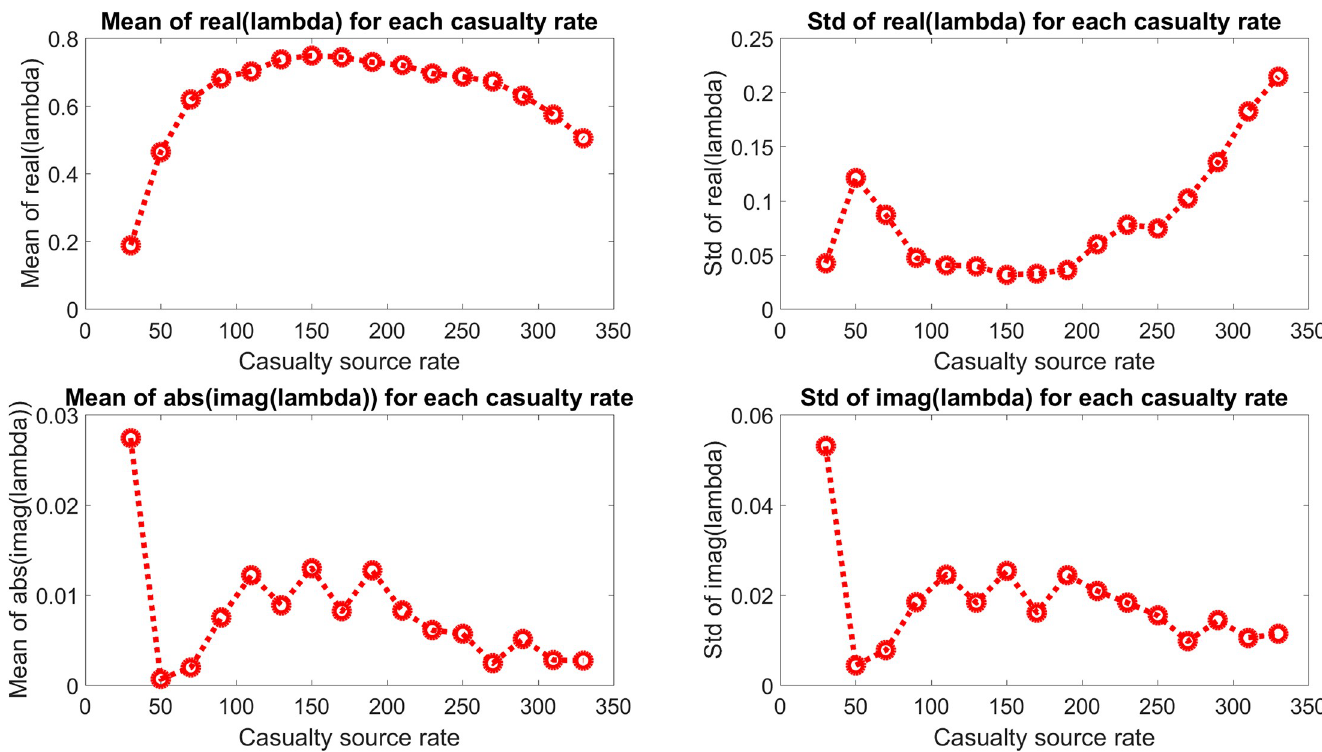
Fig 10. Mean and standard deviation of eigenvalue distribution of second mode for each casualty source rate. As in the all-eigenvalue case, the real component approaches the unit circle as the imaginary component approaches the real axis.